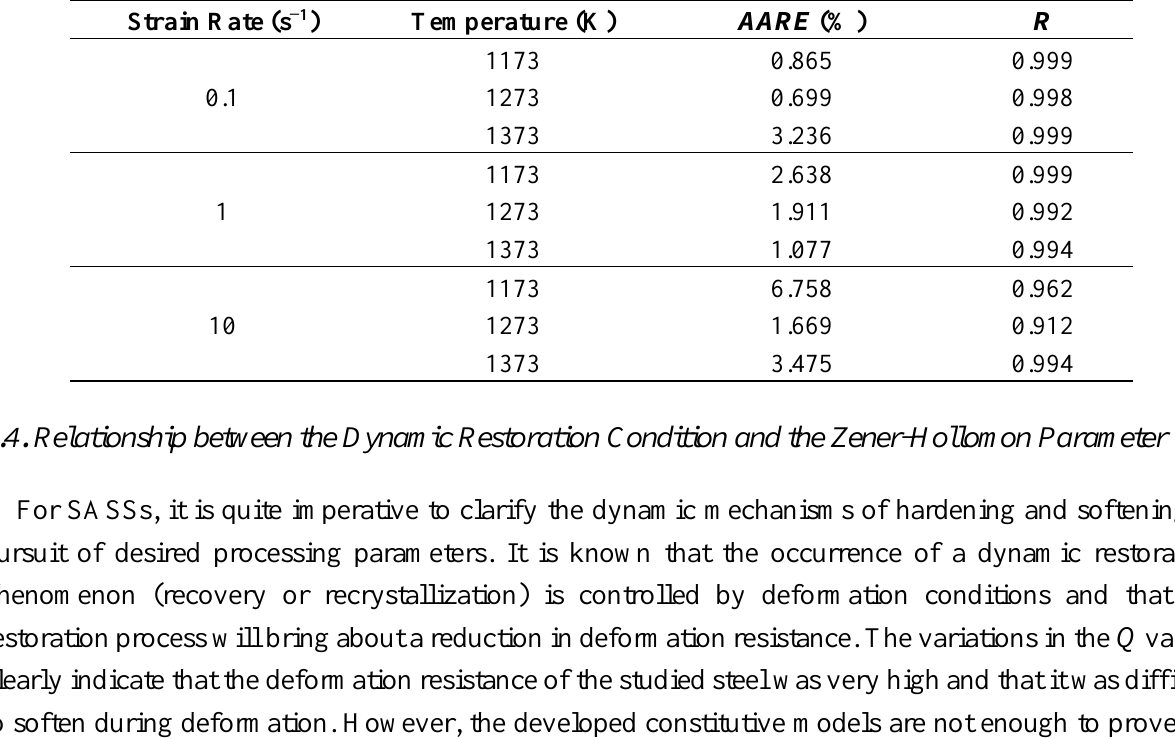
Table 3. Standard statistical parameter (average absolute relative error ( AARE ) and correlation coefficient ( R )) values corresponding to different deformation